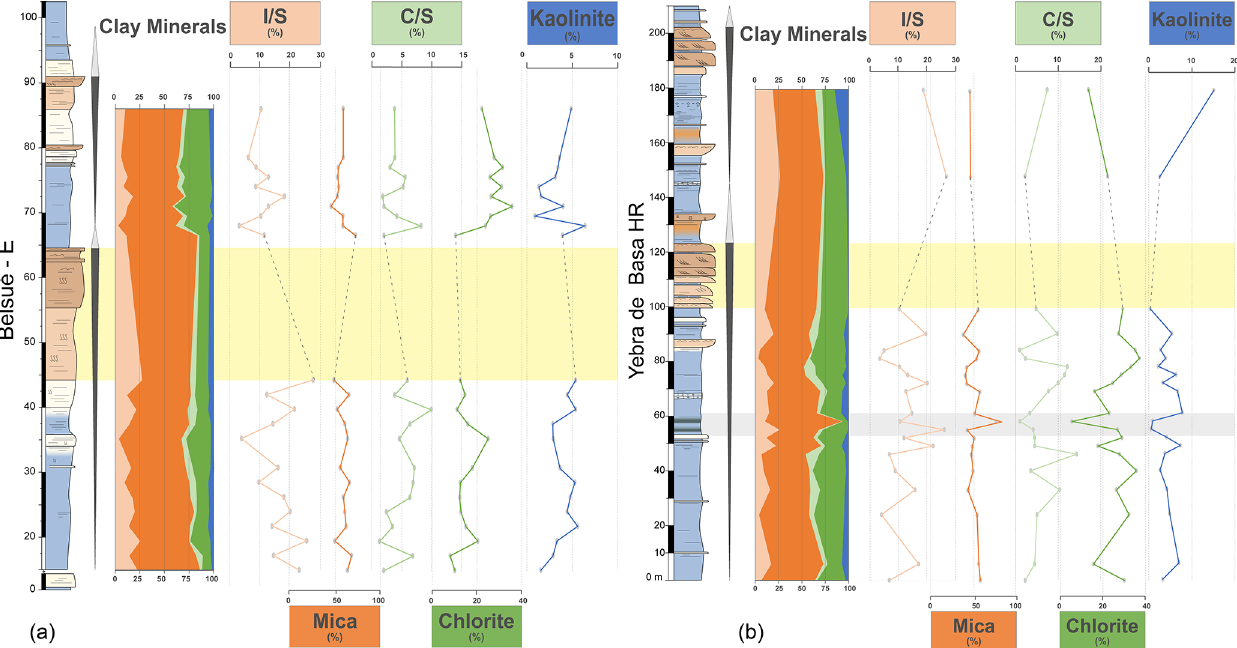
Figure 5. Schematic stratigraphic log of Belsué – E (a) and Yebra de Basa HR (b) with clay mineral assemblages, IS (illite–smectite), CS (chlorite–smectite), mica, chlorite, and kaolinite. Highlighted in pale grey is the OM-rich interval in Yebra de Basa, and in pale yellow are the main sandstone levels. The progradation–retrogradation cycles (P–R) are drawn with grey and white triangles. The dashed lines represent non-sampled intervals.